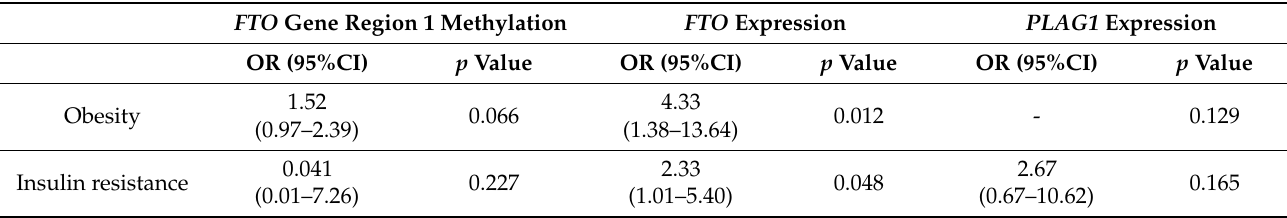
Table 6. Multiple logistic regression for obesity and insulin resistance depending on genes expression or FTO methylation. In each model the main variable was adjusted for age and sex of children, and for any interaction existing between the covariates.